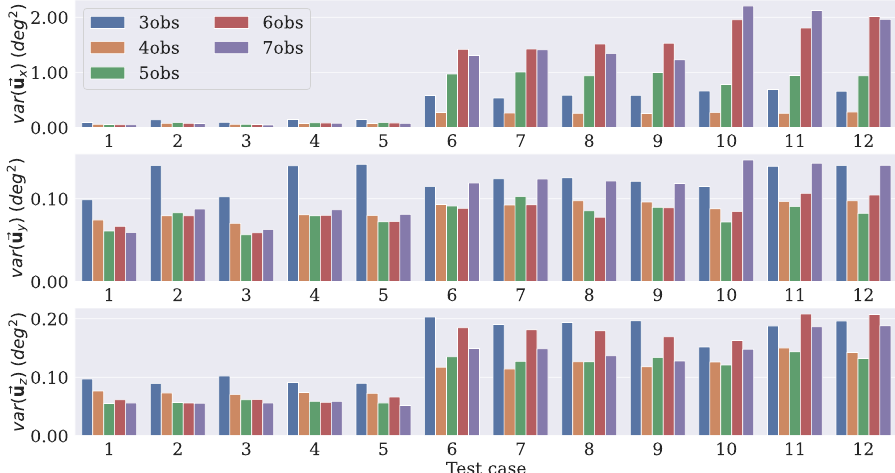
Figure 4. Uncertainties in the axes for each test case considering a dropout rate of